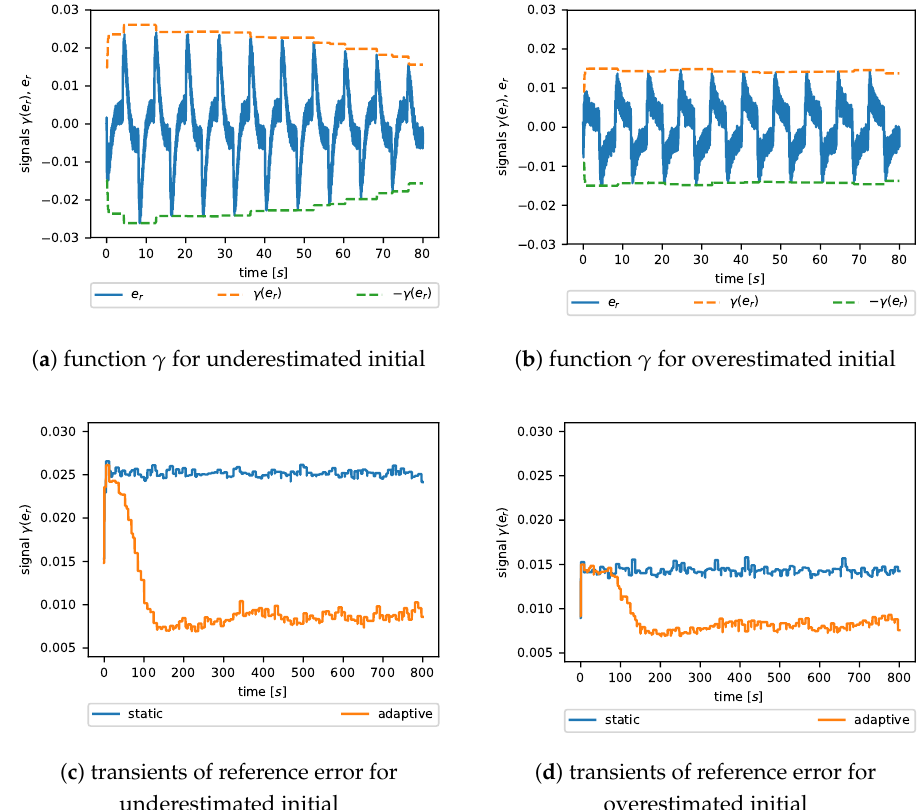
Figure 4. The transients of reference error analyzed with γ for a long